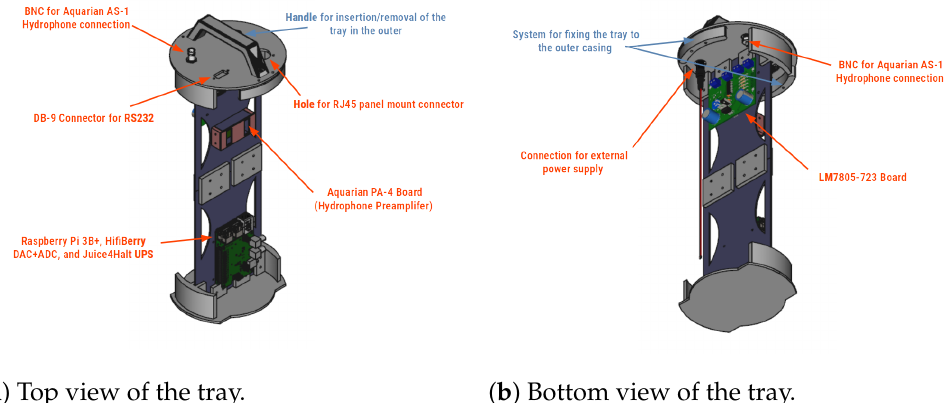
( b ) Bottom view of the tray.